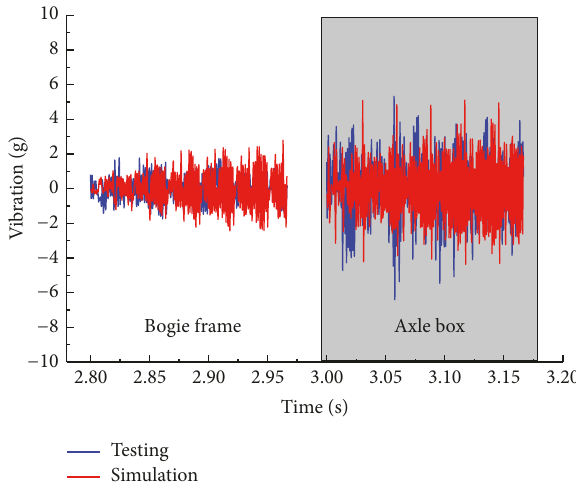
Figure 8: Vibration comparison of testing and simulation (in time